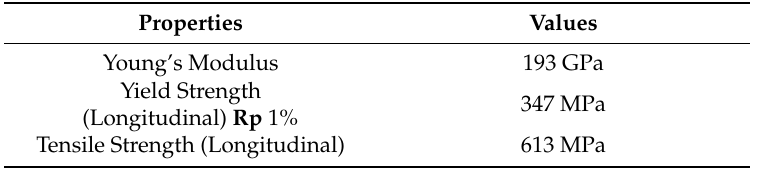
Table 4. Mechanical Properties.